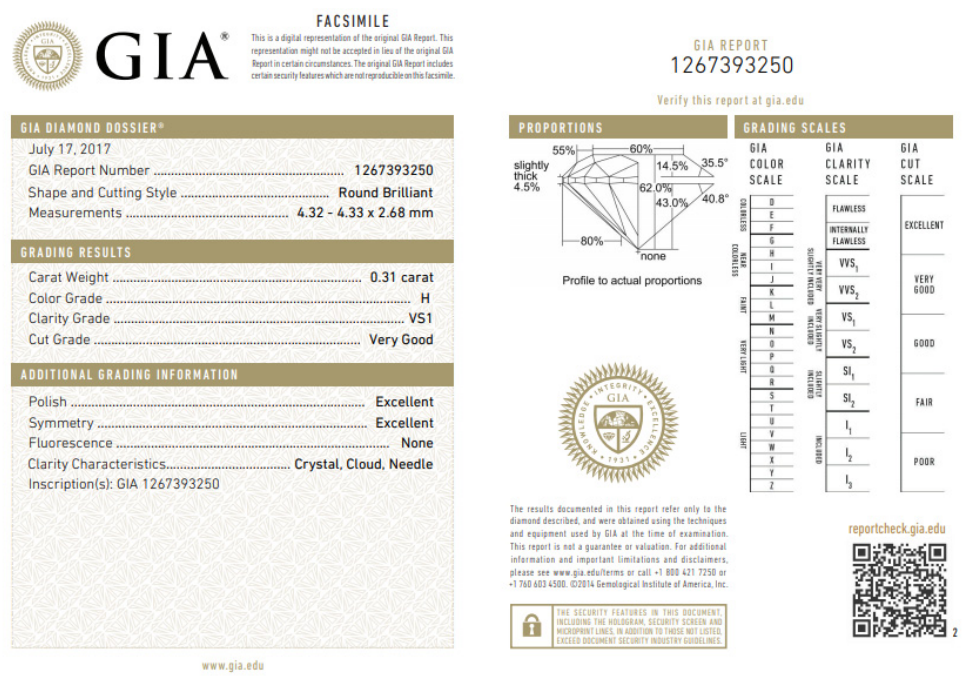
Figure 2. The GIA certificate of the H diamond.